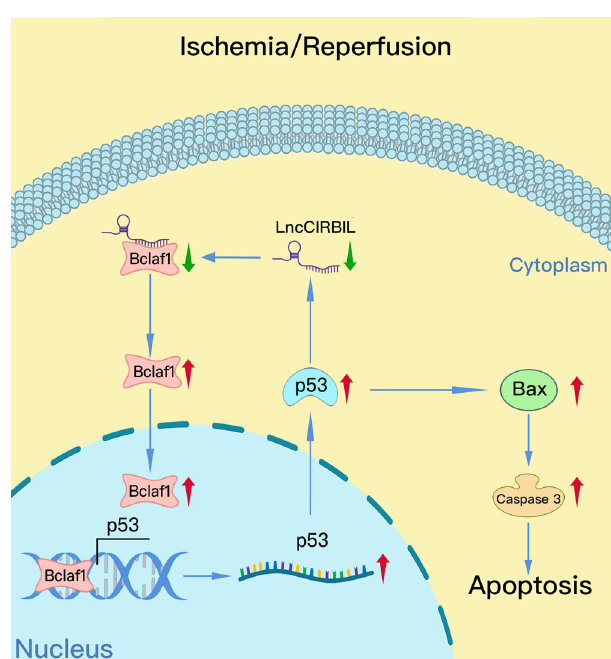
Fig. 7 Partial knockout (pKO) of Bclaf1 abrogates the exacerbating effects of lncCIRBIL knockout on cardiac ischemia – reperfusion injury. A Effects of Bclaf1 partial knockout on cardiac function of lncCIRBIL knockout mice subjected to ischemia/reperfusion injury. WT-I/R N = 12, CIRBIL-KO-I/R N = 13, CIRBIL-KO-Bclaf1-pKO-I/R N = 17, CIRBIL-KO-Bclaf1-NC-I/R N = 10. * P < 0.05 versus WT-IR, # P < 0.05 versus lncCIRBIL-KO-IR. P values were determined by one-way ANOVA test followed by Bonferroni post hoc analysis. B Infarct size measured by TTC staining (scale bar: 2 mm). WT-I/R N = 6, CIRBIL-KO-I/R N = 7, CIRBIL-KO-Bclaf1-pKO-I/R N = 10, CIRBIL-KO-Bclaf1-NC-I/R N = 7. * P < 0.05 versus WT-IR, # P < 0.05 versus lncCIRBIL-KO-IR. P values were determined by one-way ANOVA test followed by Bonferroni post hoc analysis. C , D Caspase-3 activity and cleaved caspase-3 protein level. N = 8 mice per group for caspase 3 activity, and N = 3 for cleaved caspase-3 protein level. * P < 0.05 versus WT-IR, # P < 0.05 versus lncCIRBIL-KO-IR. P values were determined by one-way ANOVA test followed by Bonferroni post hoc analysis. E Cardiomyocyte apoptosis by TUNEL assay (scale bar: 20 μ m). N = 7 mice